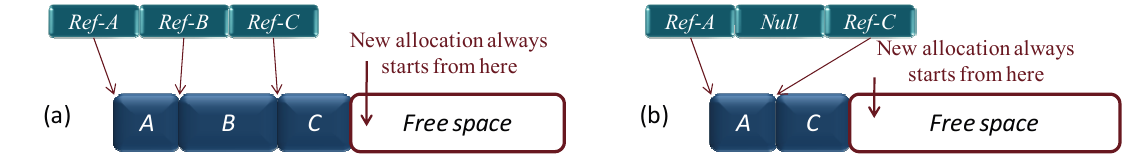
Figure 8. MIROS proactive defragmentation SF allocation. After B is de-allocated in